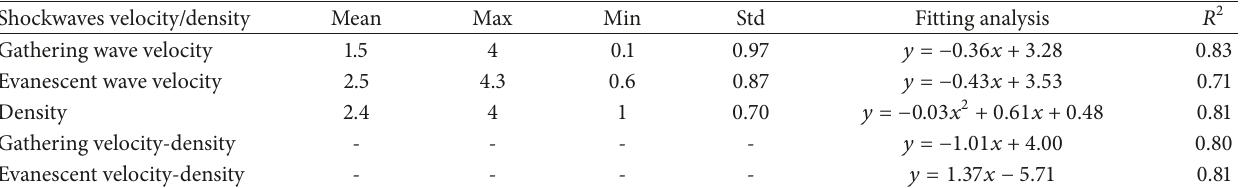
Table 4: Values of density and shockwaves velocity of pedestrian Flow.